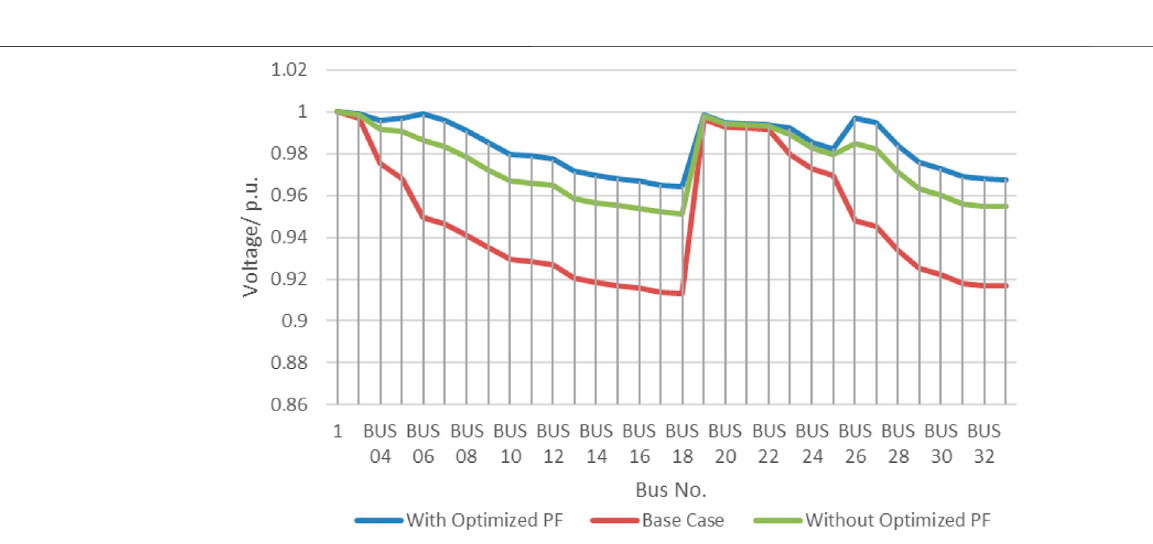
Frontiers in Energy Research |